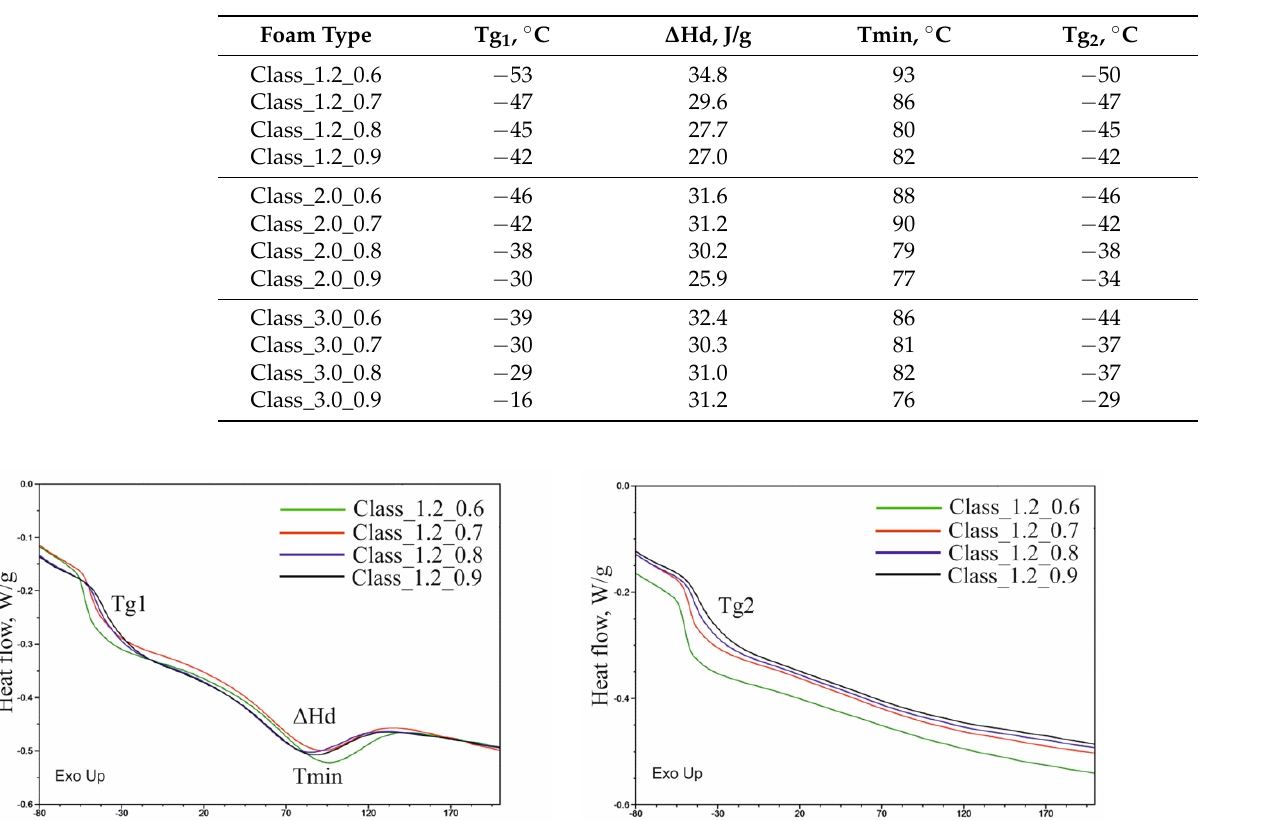
Table 5. Differential scanning calorimetry (DSC) results.